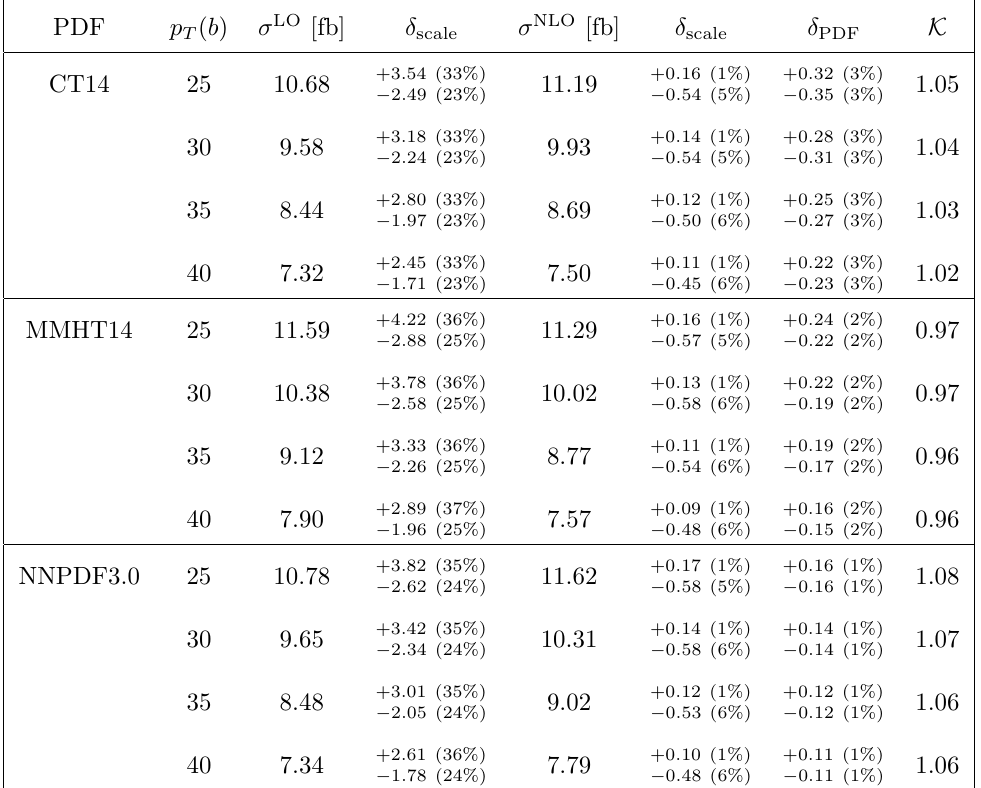
Table 1 . Integrated cross sections for the pp with p s = 13 TeV. Results are evaluated using (cid:22) R = (cid:22) F = (cid:22) 0 = H T = 4 for three di(cid:11)erent PDF sets and four di(cid:11)erent p T ( b ) cuts for the b -jets. Also given are theoretical uncertainties coming from scale variation, (cid:14) scale , and from PDFs, (cid:14) PDF . In the last column a as = (cid:27) NLO =(cid:27) LO , is K